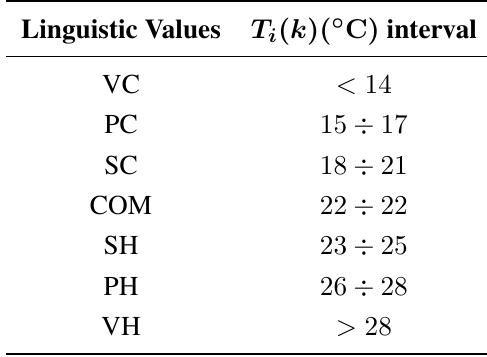
used for the winter scenario. i